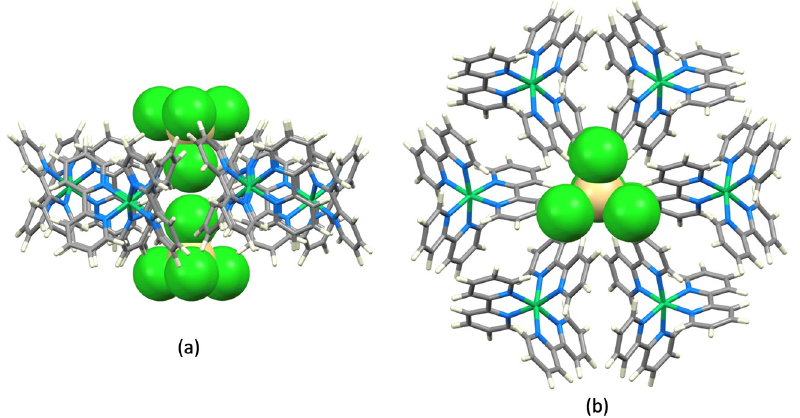
Figure 13. Structure Type II motif in [Ni(bpy) 3 ][CdCl 4 ] (refcode BINZON) [82] viewed ( a ) from the side and ( b ) from above.